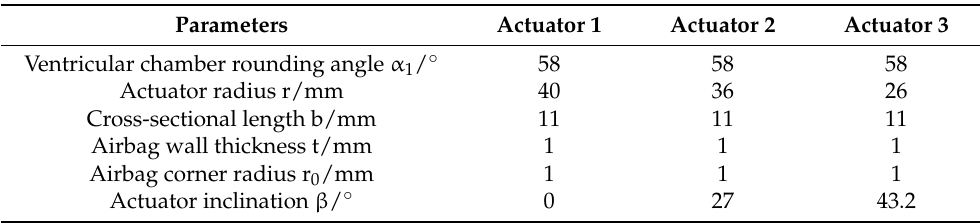
Table 1. Preliminary determination of the structural parameters of the fiber-constrained annular flexible